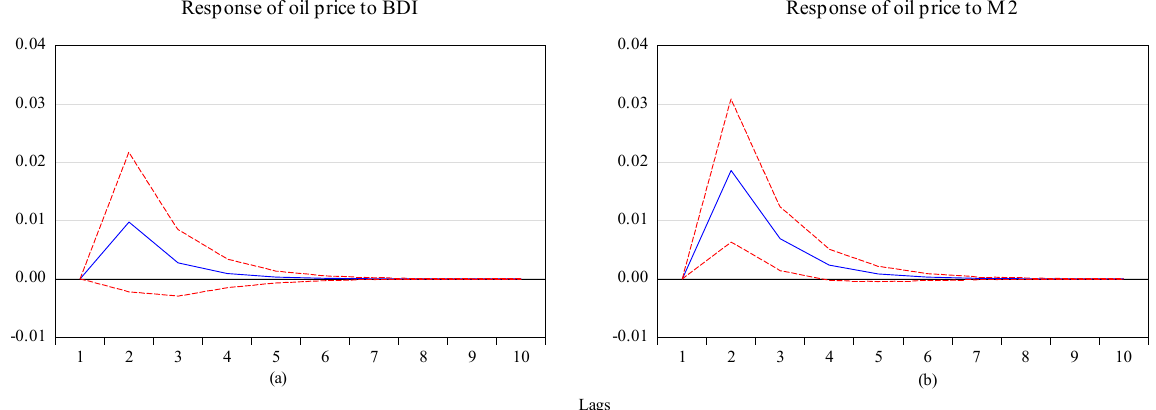
Figure 1. Identification of oil’s commercial and financial attributes. Notes: ( a ) refers to the identification of oil’s commercial attribute, and ( b ) is the identification of oil’s financial attribute.